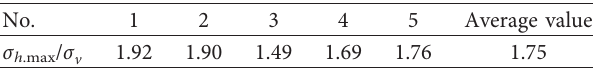
Table 9: Ratio of the maximum horizontal principal stress to minimum horizontal principal stress.